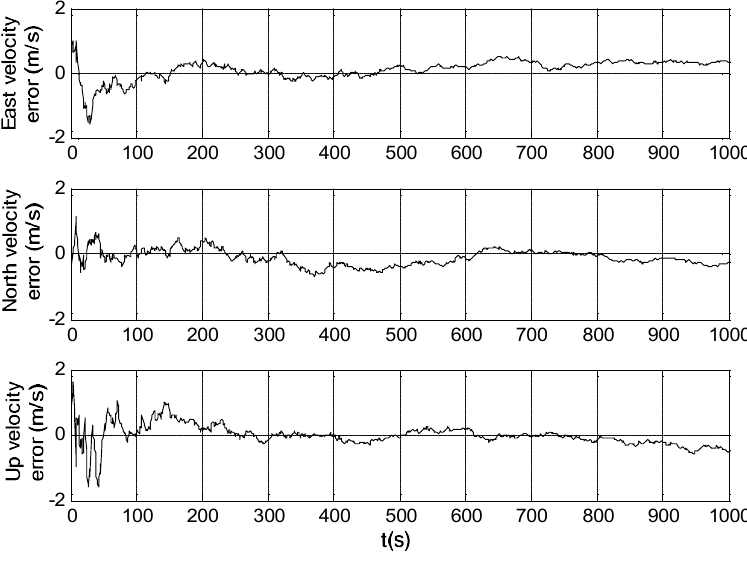
Figure 10. Velocity error of SINS/SRS/SS integrated navigation system.